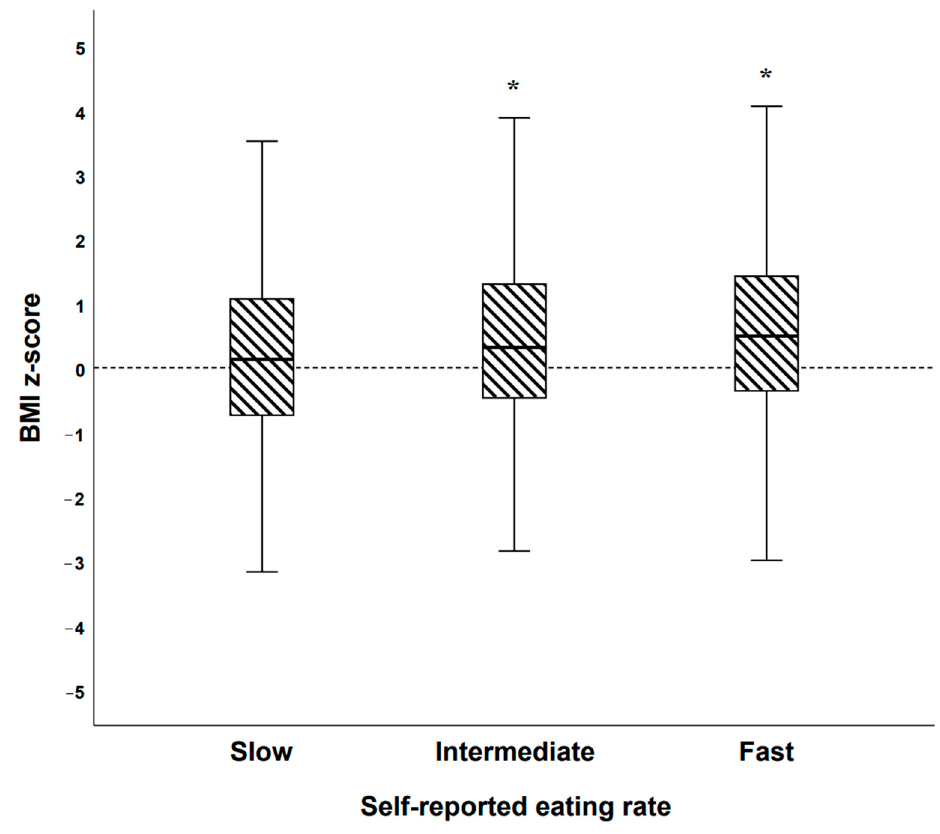
Figure 9. Boxplot illustrating BMI z-scores among self-reported categories of eating rate in the BigO cohort ( n = 1832). * = significantly different vs. self-rated slow eaters.